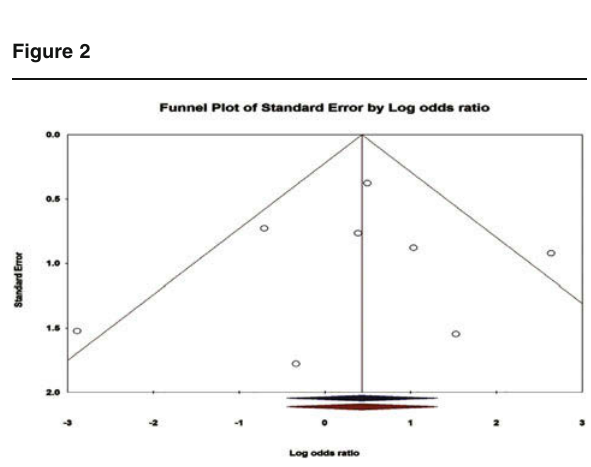
Funnel plot of the log odds ratio and the SE of odds ratio for determination of publication